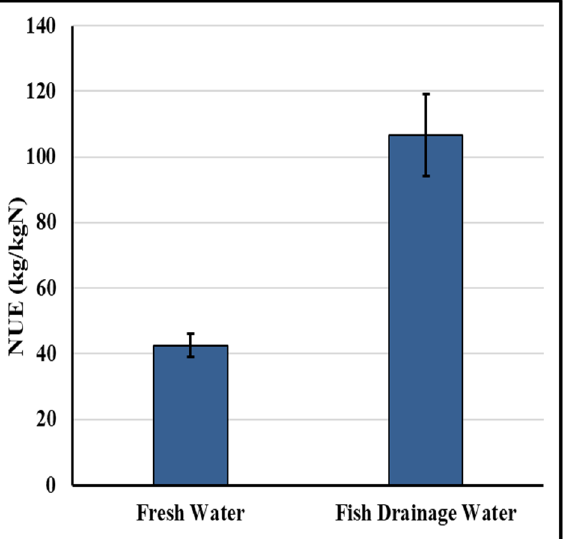
Figure 4. Effect of fresh and fish drainage water in combination with different organic fertilizers on NUE.).